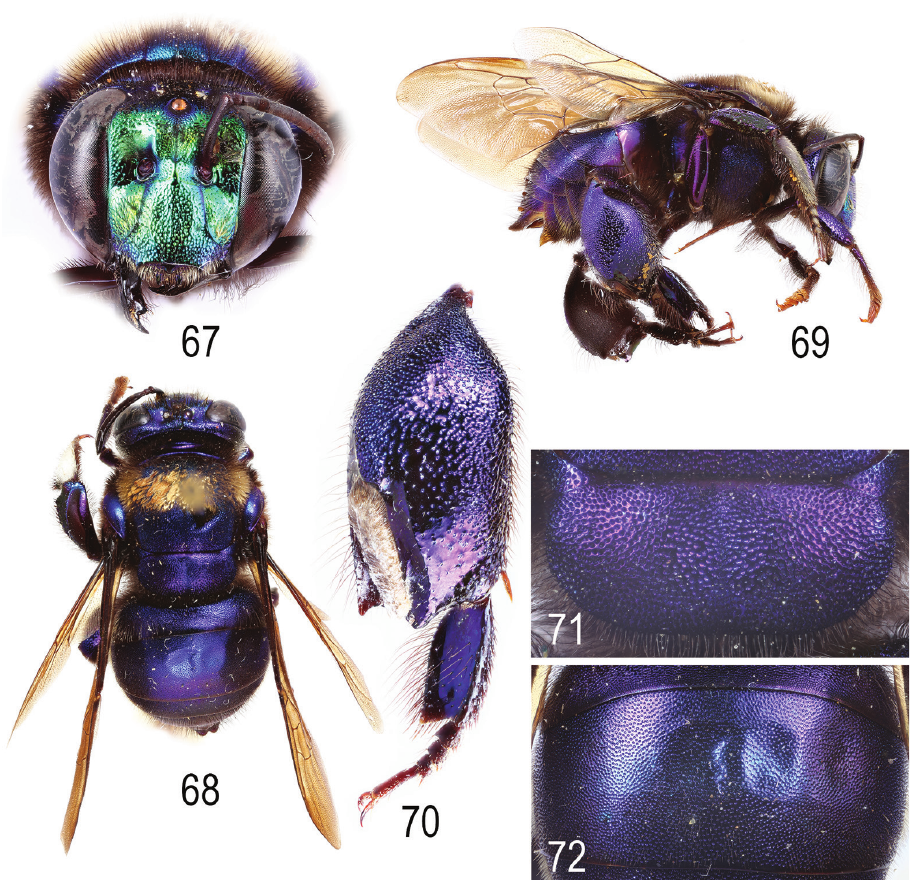
Figures 67–72. Male holotype of E. simillima (except paratype in Fig. 70; Mexico: Chihuahua, Barran- ca del Cobre, KUNHM-ENT 0504566). 67 Facial view 68 Dorsal habitus 69 Lateral habitus 70 Outer view of hind leg; 71 Dorsal view of mesoscutellum 72 Second metasomal tergum.